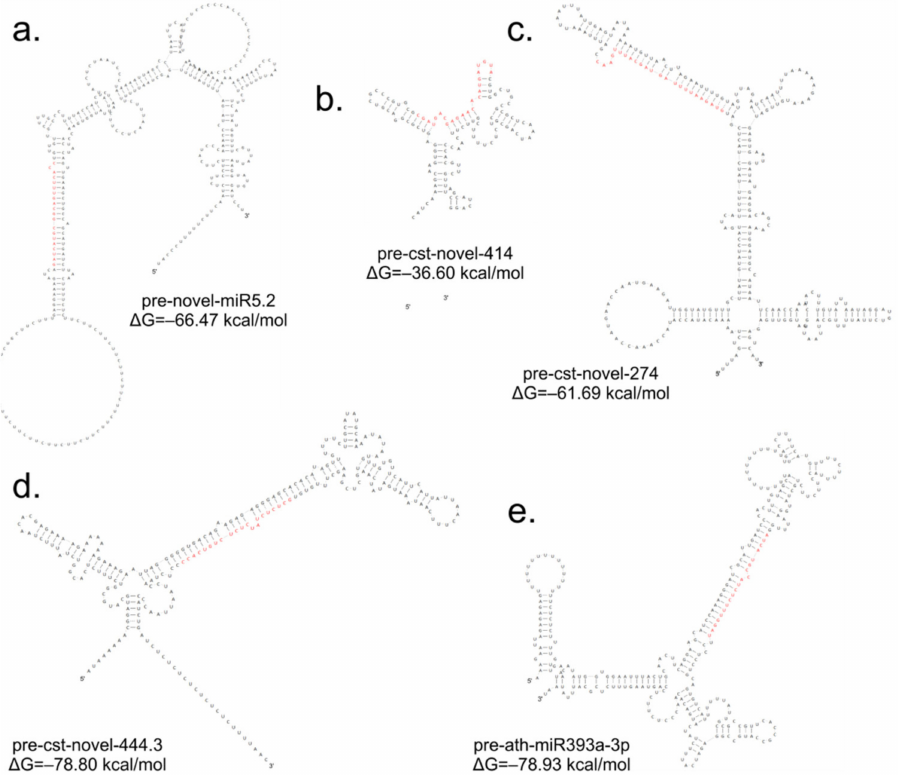
Figure 6. Stem-loop structures of the selected cucumber pre-miRNAs: ( a ) pre-cst-novel-miR5.2; ( b ) pre-cst-novel-miR414; ( c ) pre-cst-novel-miR274; ( d ) pre-cst-novel-miR444.3; ( e ) pre-ath-miR393a-3p. Red letters represent miRNA. Structures with the lowest free energy are presented, which reflects the most stable miRNA structures.